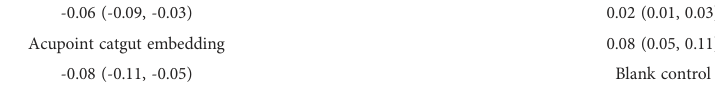
TABLE 9 Network meta-analysis ladder table of waist – hip ratio.